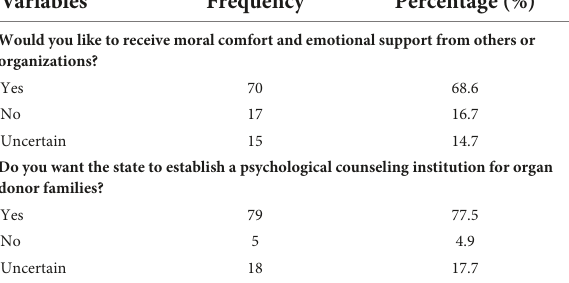
TABLE 6 Emotional support needs of the donor’s families ( N =